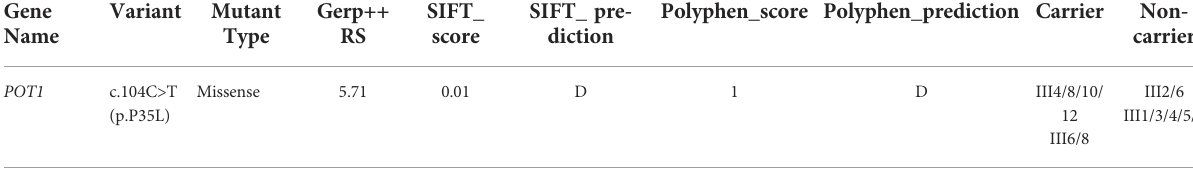
TABLE 3 List of POT1 associated with cancer development in the LFL